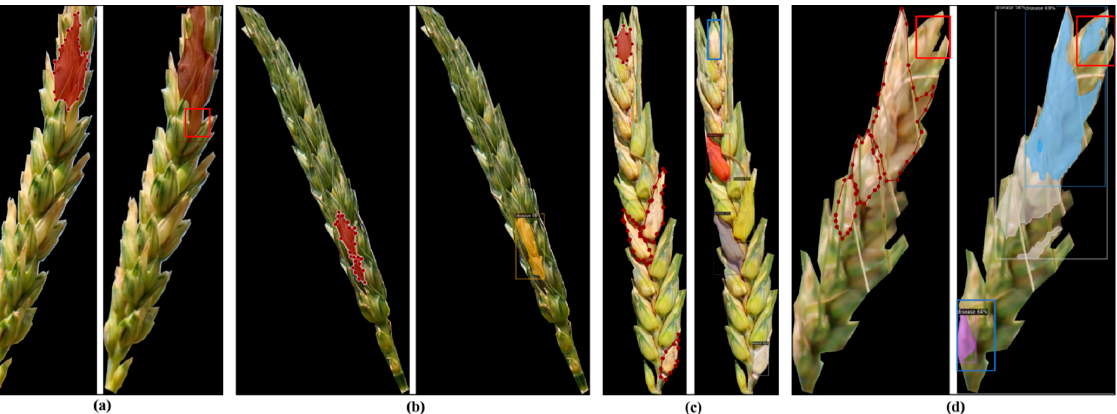
Figure 9. The detection of diseased areas in selected wheat sub-images in the validation dataset: ( a – c ) examples of detection failures caused by model errors; ( d ) an example of detection failure caused by model error or annotation